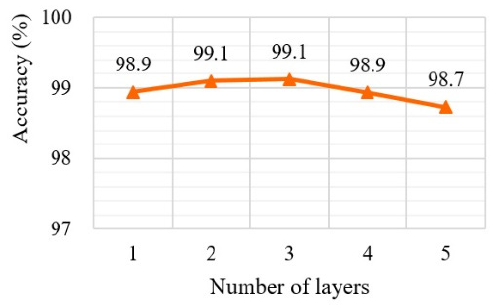
Figure 3. Performance evaluation results according to number of layers with e d ≤ 0.05 using GI4E dataset.